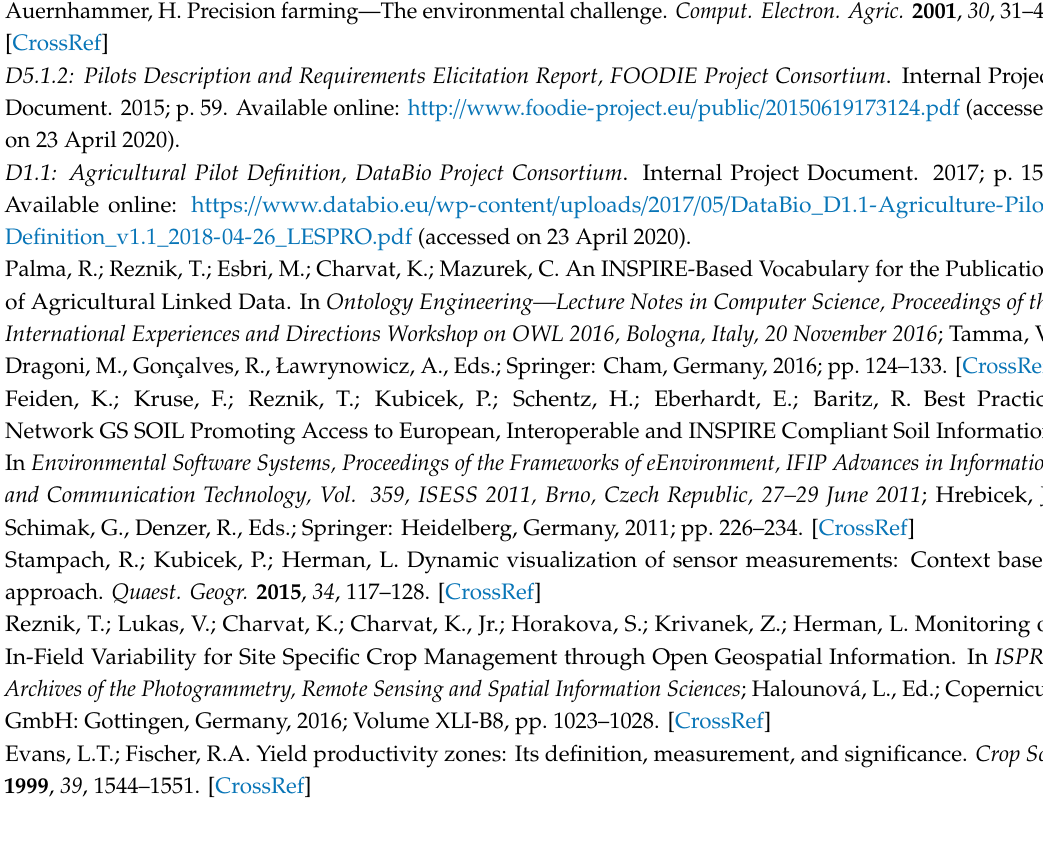
Table S1: Overview of satellite imagery from Landsat mission used for the calculation of yield zones; Table S2: Overview of satellite imagery from Sentinel-2 mission used for the calculation of yield